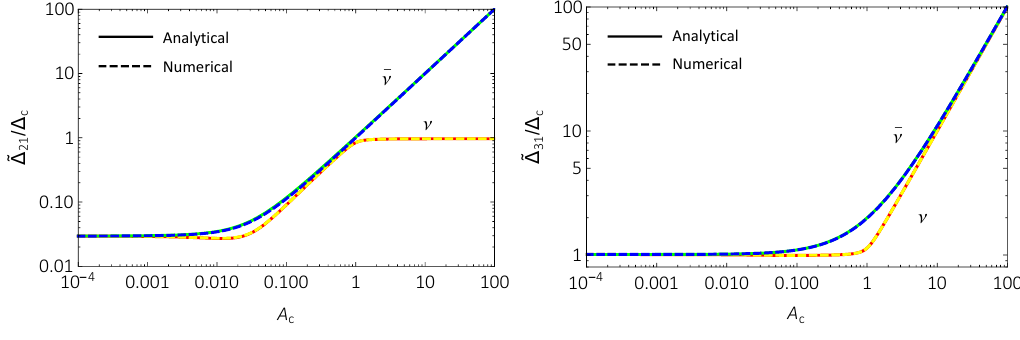
= (cid:1) ( left panel ) and e (cid:1) = (cid:1) ( right panel ) in c c 21 31